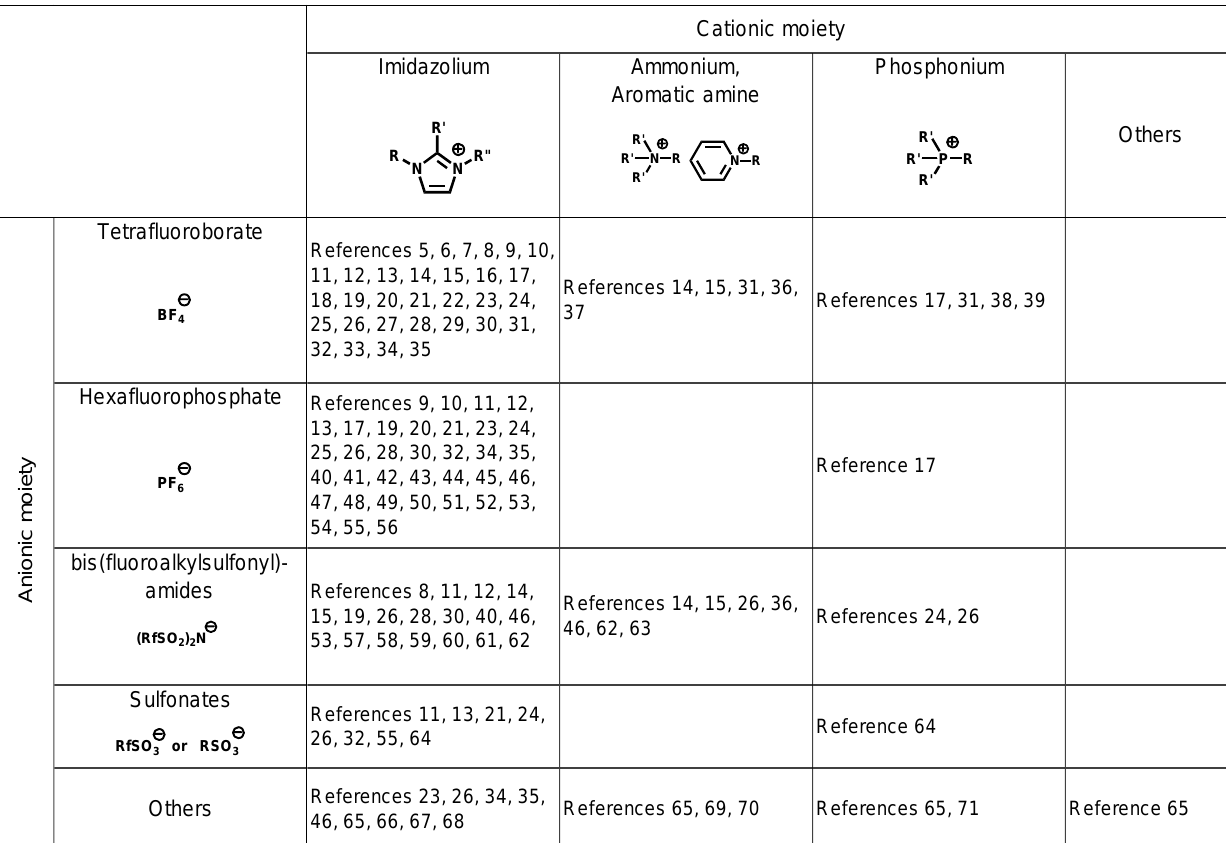
Table 1. Reported anions and cations mentioned in articles on